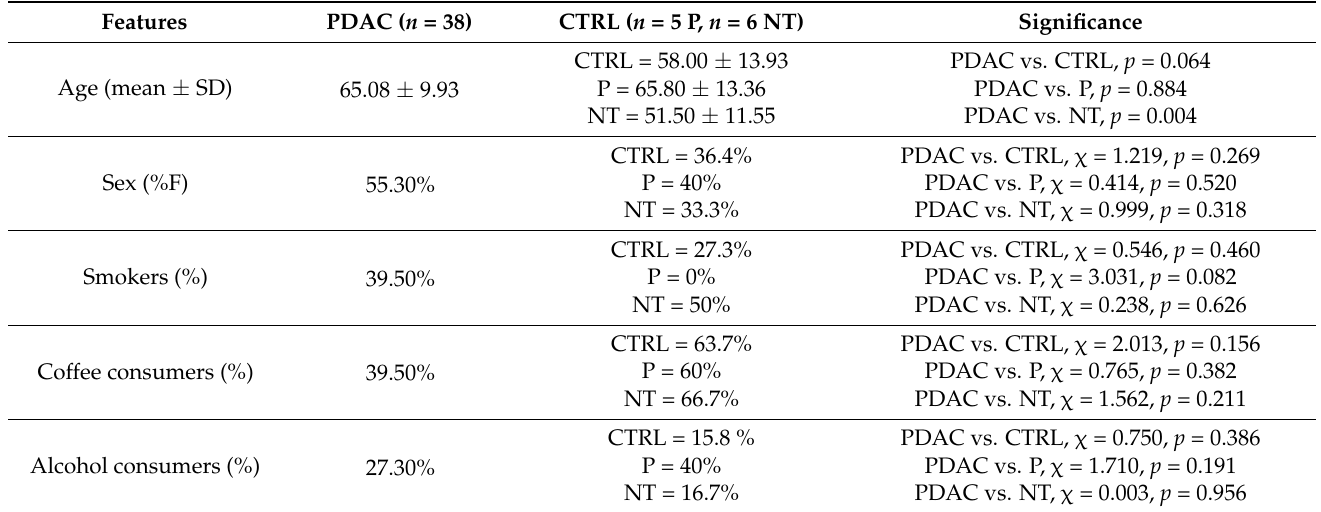
Table 1. Sociodemographic and lifestyle data of patients and controls enrolled in the study.